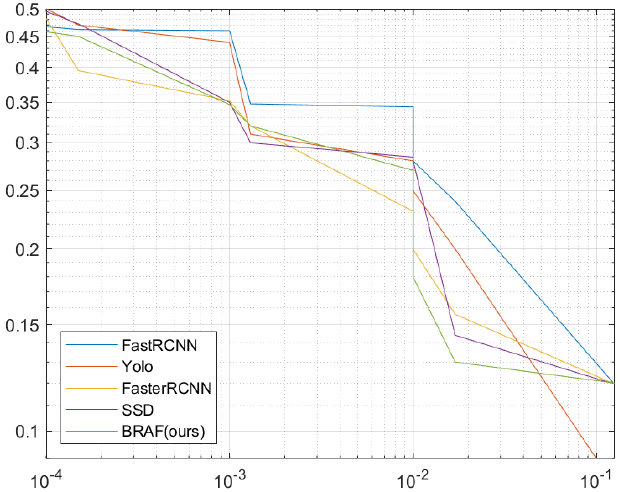
Figure 9. Missing Rate (MR) versus False Positive Per Character (FPPC) for finding the centers of characters in heatmaps for comparison of our FC-MSCCD model with other SOTA models. Figure 10 shows the vitalization results of the Gaussian heatmaps.